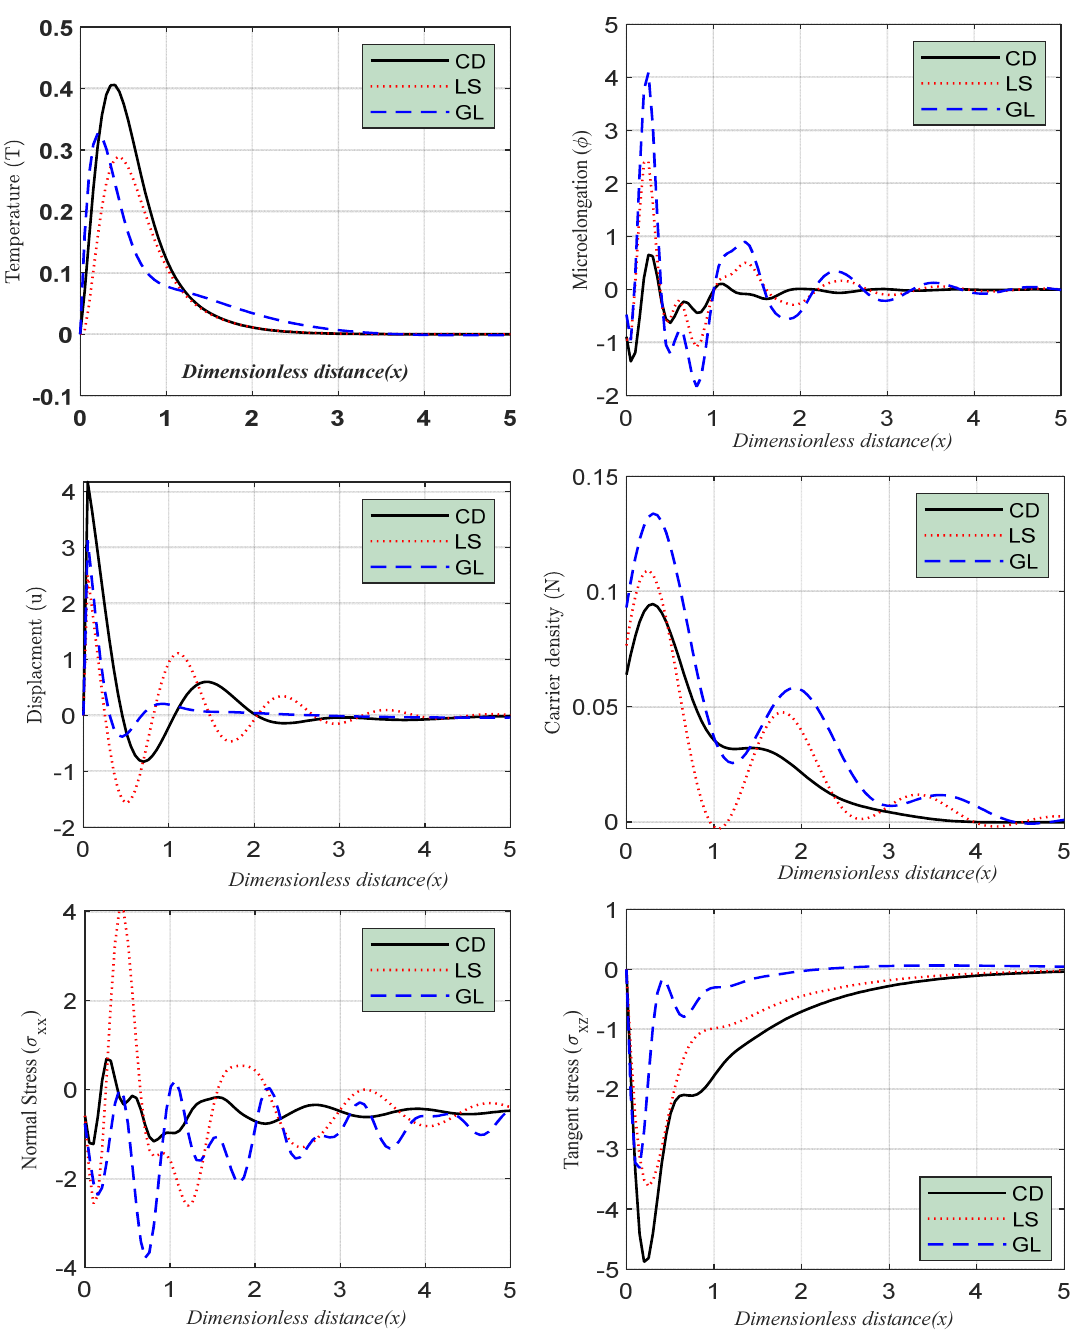
Figure 2. The wave propagations of the physical fields with the horizontal distance according to the different microelongation magneto-photo-thermoelasticity models.